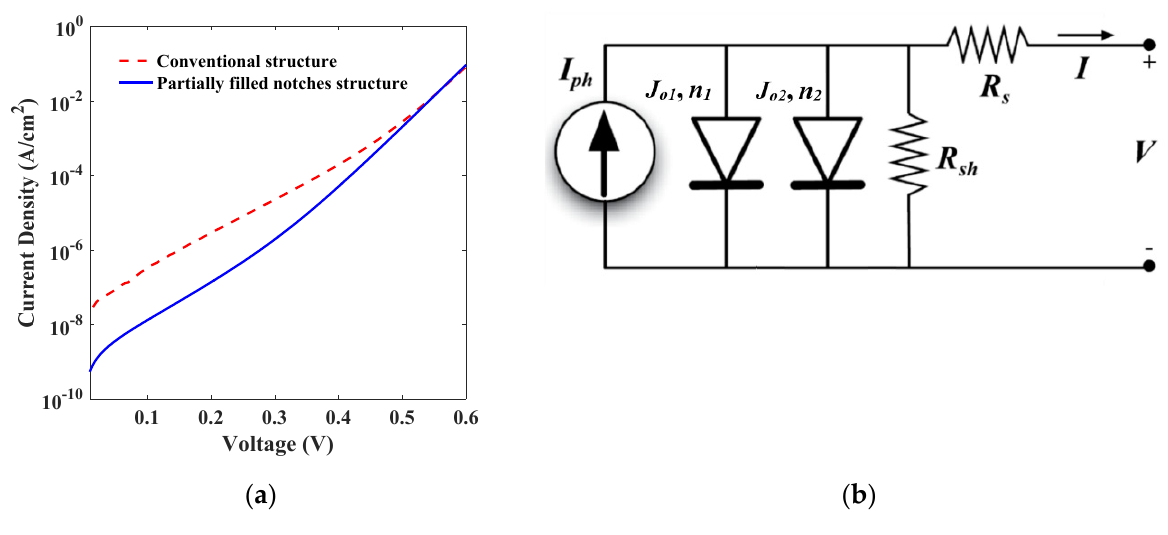
Figure 4. ( a ) A comparison between the dark characteristics of the conventional npn and partially- filled-notches structures and ( b ) equivalent two-diode model. Table 2. Two diode model parameters for the conventional and partially-filled notches microstructures.